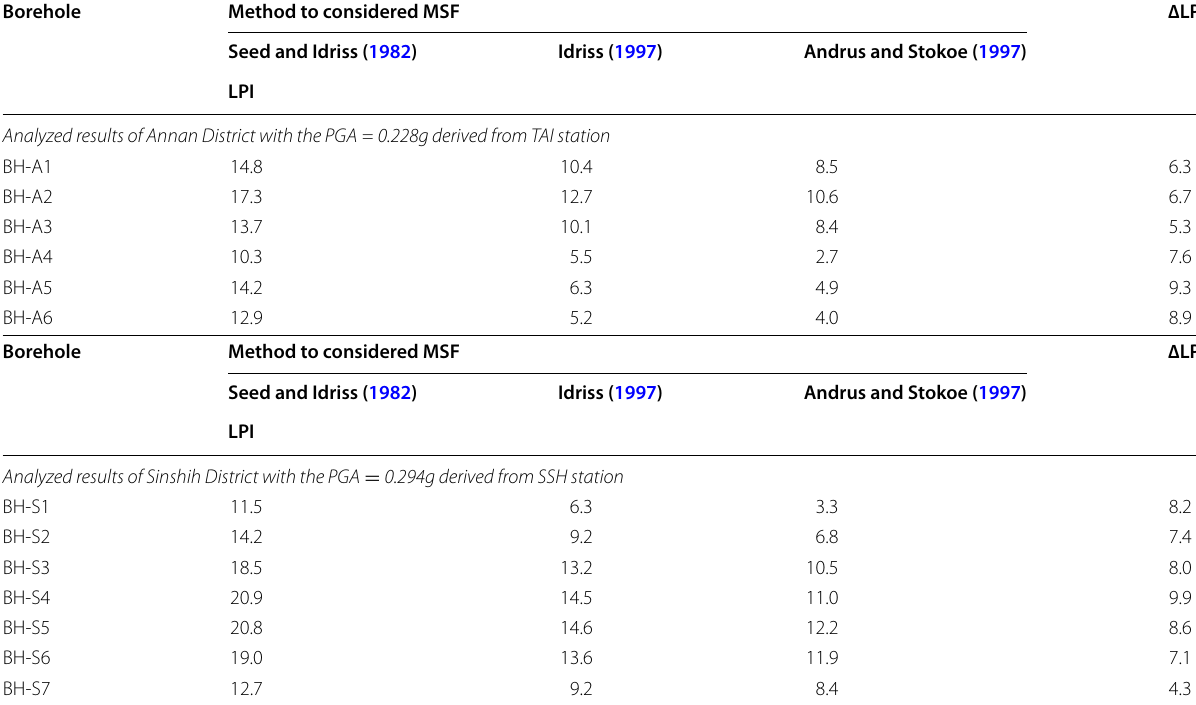
Table 8 The effect on LPI evaluation due to the